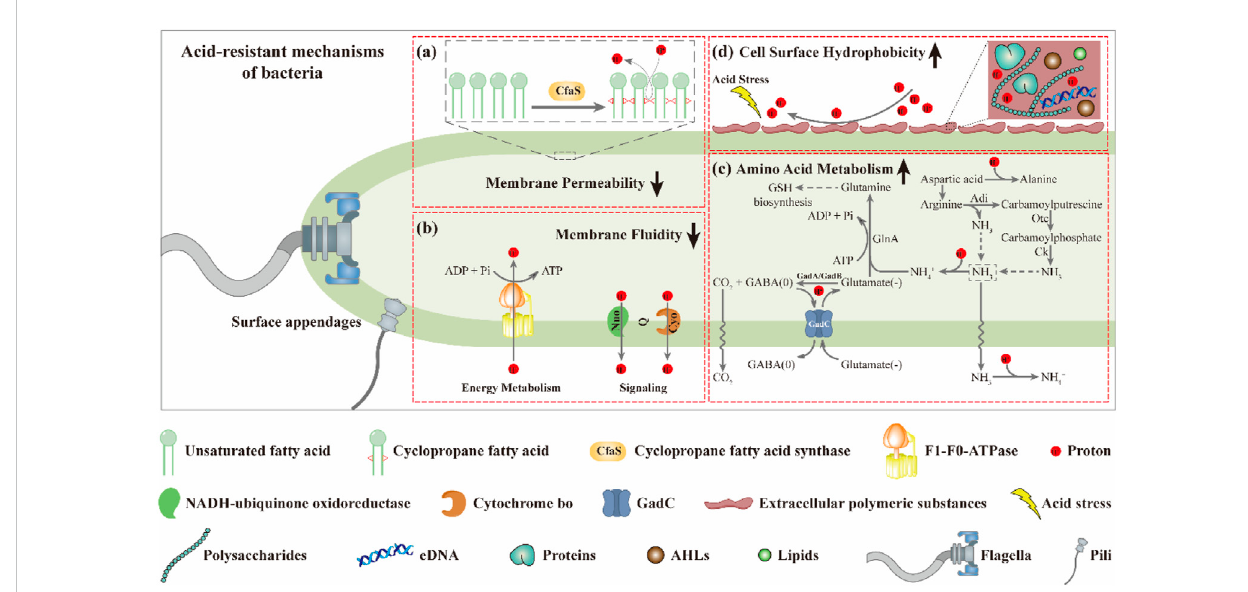
FIGURE 8 The CfaS-mediated cell membrane remodeling favors bacterial resistance to environmental acid stress. The heterologous expression of Accfa 2 led to a signi fi cant decrease in the membrane permeability (A) and fl uidity (B) of bacteria. Under acid stress, the intracellular amino acid metabolism of bacteria was enhanced (C) , and the relative hydrophobicity of the cell surface was increased (D)